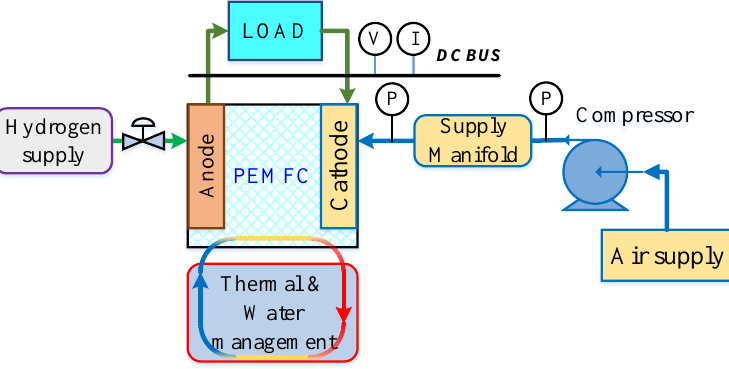
Figure 1. Architecture of PEMFC system.